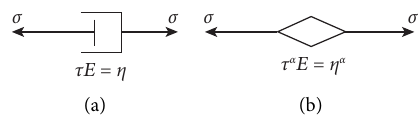
Figure 5: (a) Newton dashpot and (b) spring-pot or Abel dashpot.